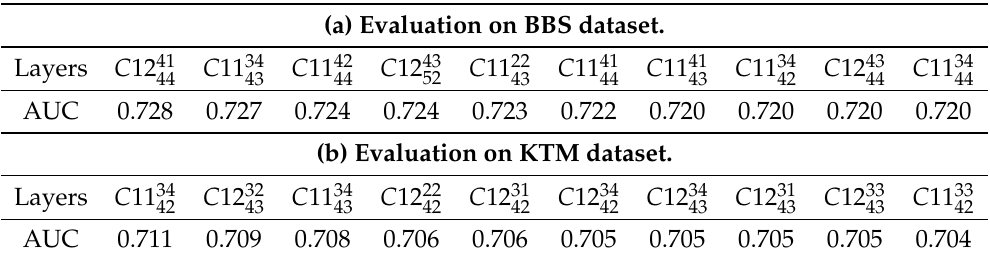
Table 3. Best ten results when using combinations of features from three convolutional layers of Model_D; here, for instance, C 12 41 means that features from conv1_2 , conv4_1 , and conv4_4 were fused. 44 (a) Evaluation on BBS